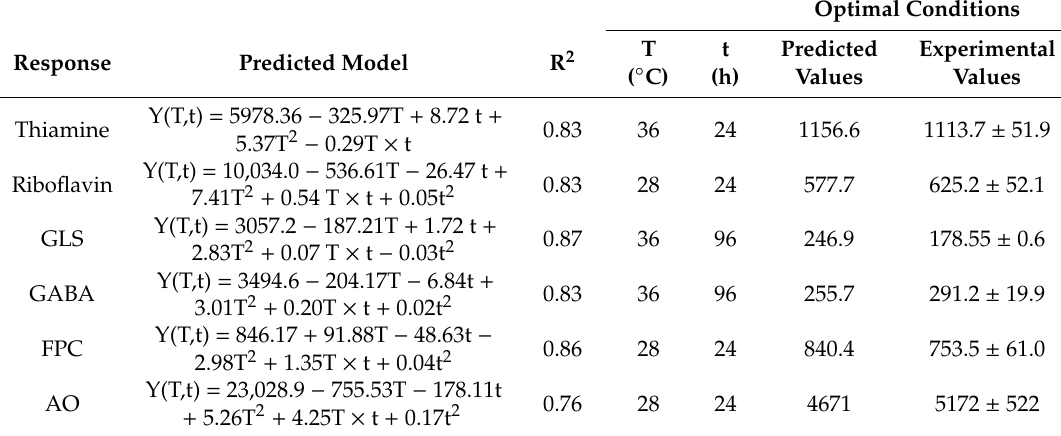
Table 5. Predictive polynomial equations obtained by RSM and the predicted and experimental values for thiamine, riboflavin, GLS, GABA, FPC contents and antioxidant activity in the optimal germination